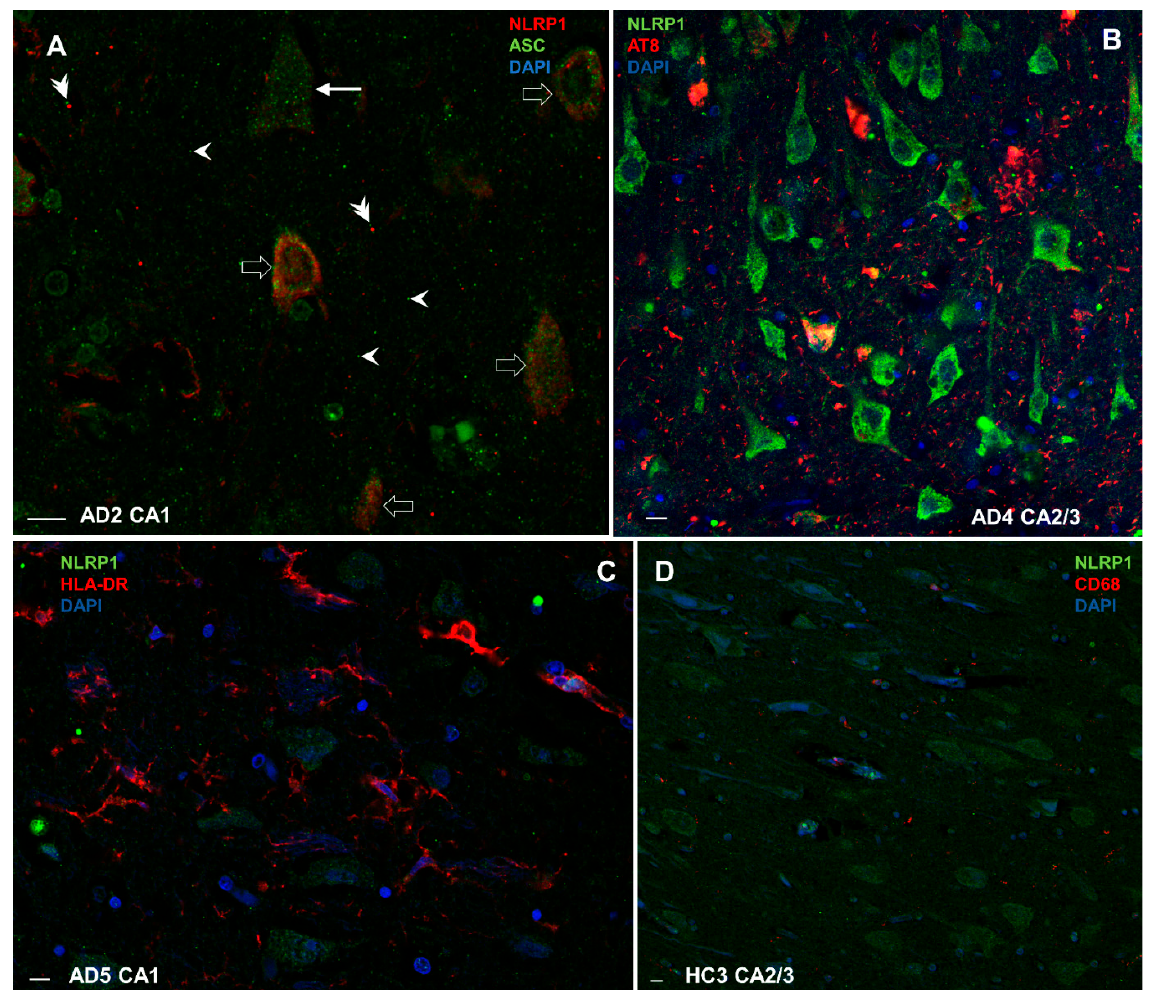
Figure 11. Colocalization of NLRP1 with ASC, phosphorylated tau (AT8), CD68, and HLA-DR in Alzheimer’s disease ( A – C ) and healthy control hippocampus ( D ). Open arrows in A show neurons in which NLRP1 inflammasome colocalizes with ASC protein. Full arrow in A shows presence of ASC proteins in a neuron in absence of NLRP1 inflammasome. Arrowheads in A show larger and brighter ASC signals that probably correspond to aggregates of self-oligomerized ASC protein, which are sometimes in the extracellular spaces of AD brains in association with NLRP1 (double arrowheads in A ). AD brains generally show much higher expression of NLRP1 inflammasome ( A and B ) and HLA-DR-immunoreactive microglial cells ( C ) than healthy control brains ( D ). Scale bars = 10 μ m.